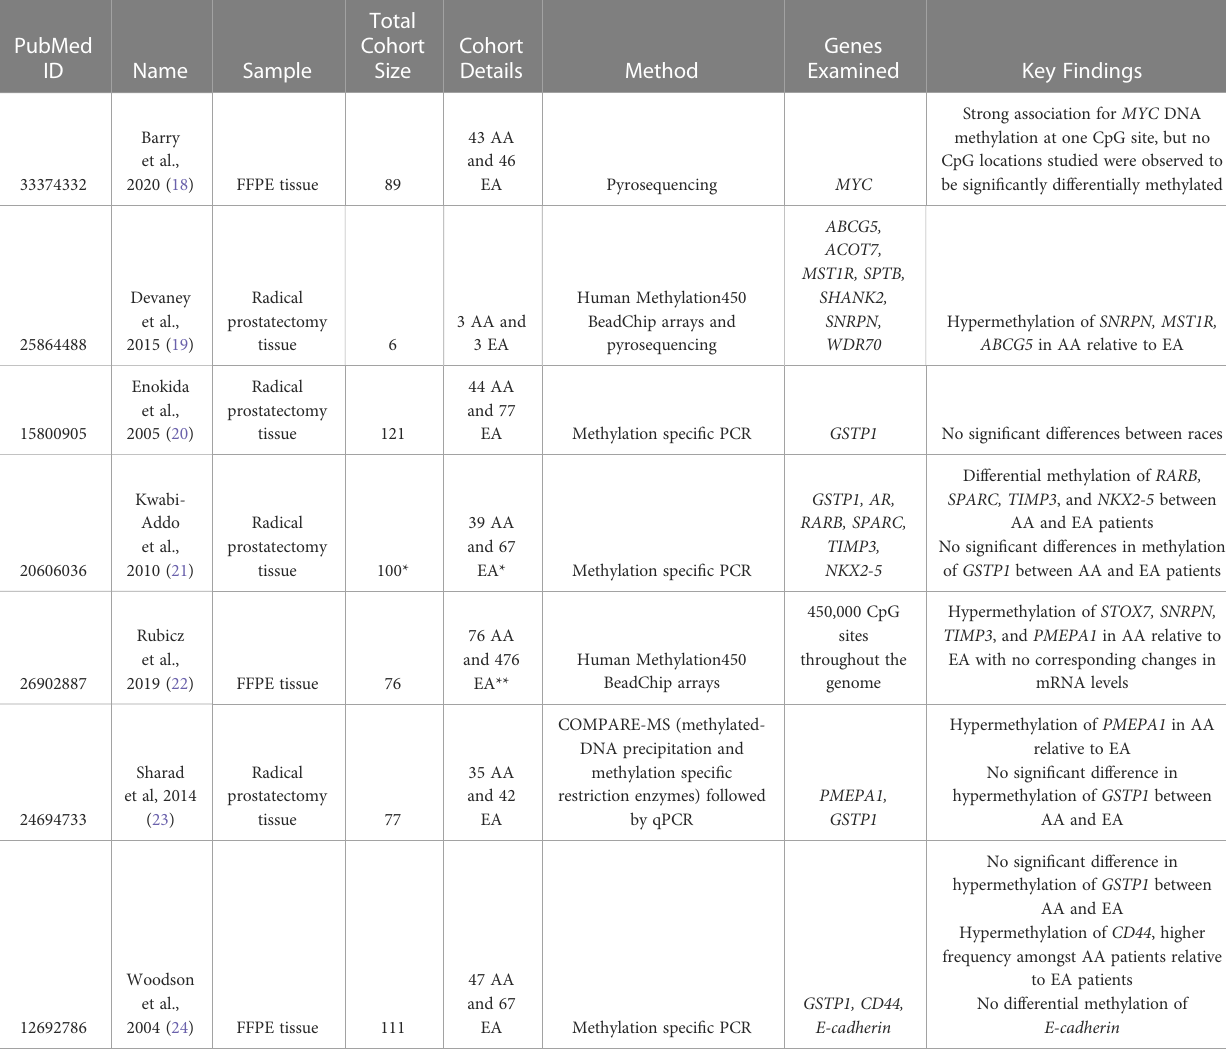
*Based on Table 1 of Kwabi-Addo et al. (21) **Generated as part of a previous study. FFPE, Formalin- fi xed, paraf fi